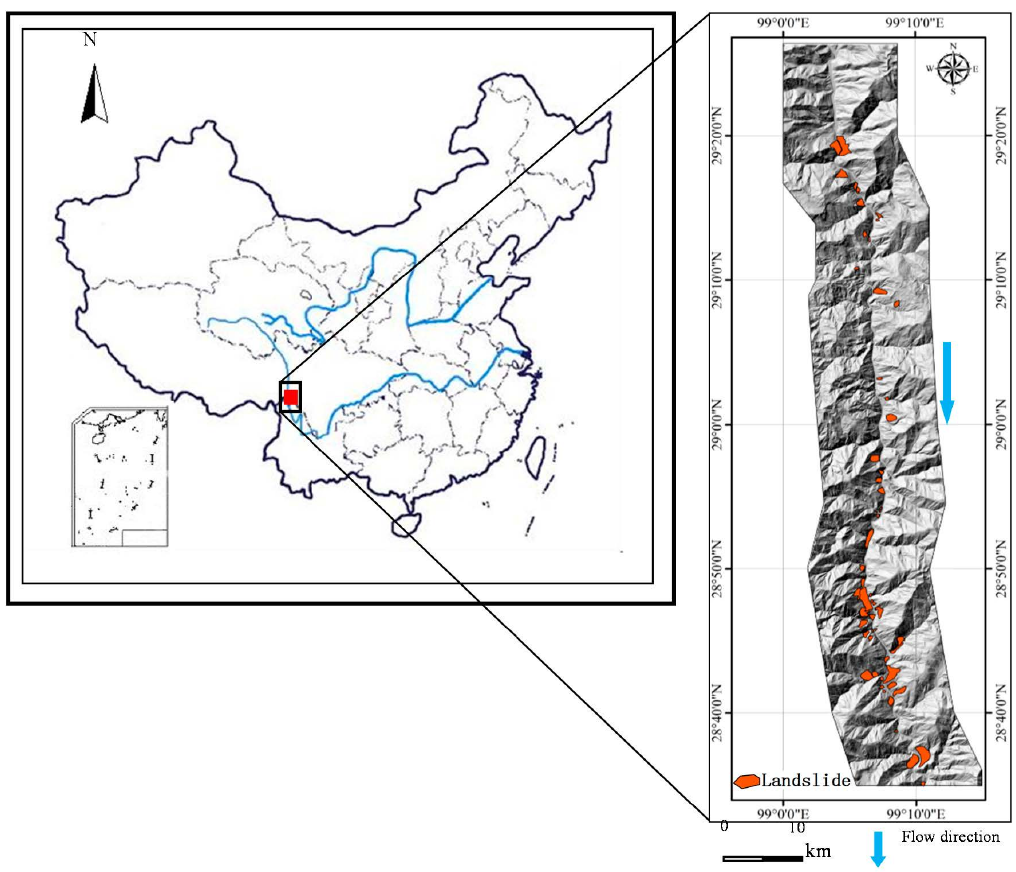
Figure 1. Geographical position of the reservoir area of Xulong hydropower station.